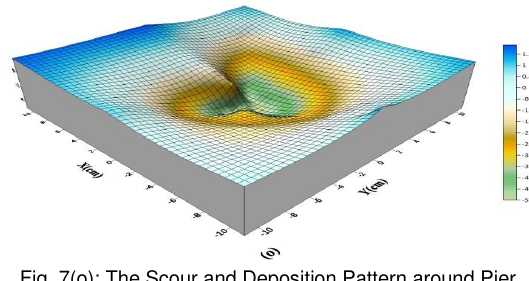
Fig. 7(k): The Scour and Deposition Pattern around Pier (P 1 ) at angle 15 0 and flowrate 14 L/Sec.